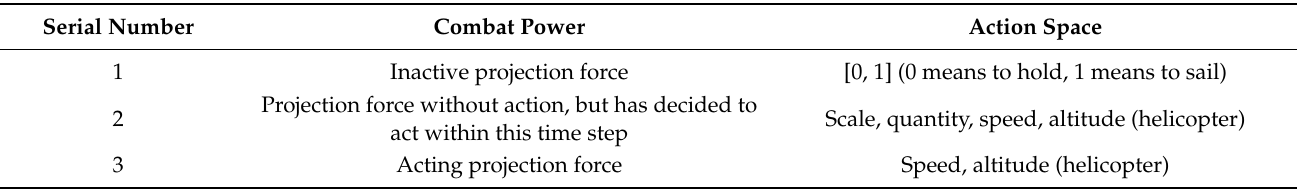
Table 2. Action space in one time